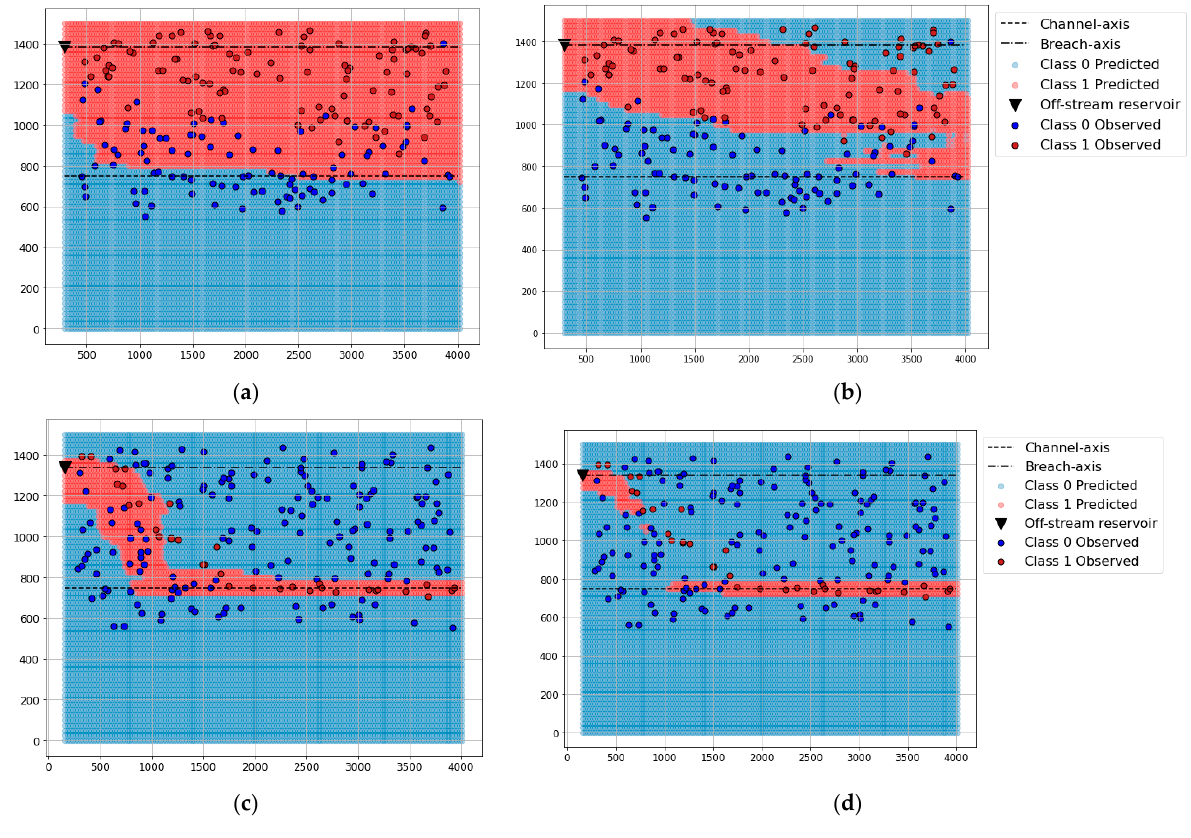
Figure 5. Map classification of potential hazard due to off-stream reservoir failure predicted with RF models and results from Iber. ( a ) Results with RF-OS model synthetic case 084 (Manning coefficient: 0.025 s/m 1/3 ). ( b ) Results with RF-US model synthetic case 084 (Manning coefficient: 0.025 s/m 1/3 ). ( c ) Results with RF-OS model synthetic 099 (Manning coefficient: 0.05 s/m 1/3 ). ( d ) Results with RF-US model synthetic case 099 (Manning coefficient: 0.05 s/m 1/3 ).